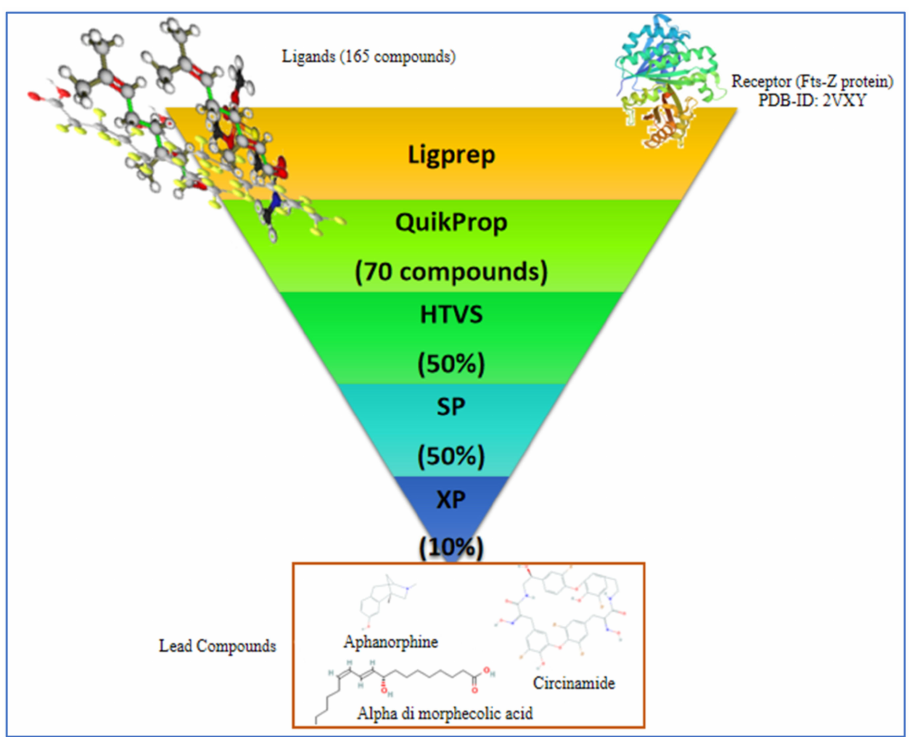
Figure 3. Schematic figure showing steps followed during virtual screening of compounds. Glide initially places the center of the ligand at different grid points of 1 Å and rotates them around three Euler angles. Then, filtration is conducted based on grid-based force field evaluation and then further refinement of docking solutions is completed by torsional and rigid body ligand movements. The overall final energy assessment is completed with Glide Score and, for each ligand, a final best posture is generated as the output. The Glide Score is calculated by summing ligand–protein interaction energy, hydrophobic interactions, π – π stacking interactions, hydrogen bonds, internal energy, RMSD (root mean sq. deviation of protein before and after docking), and desolvation scores.